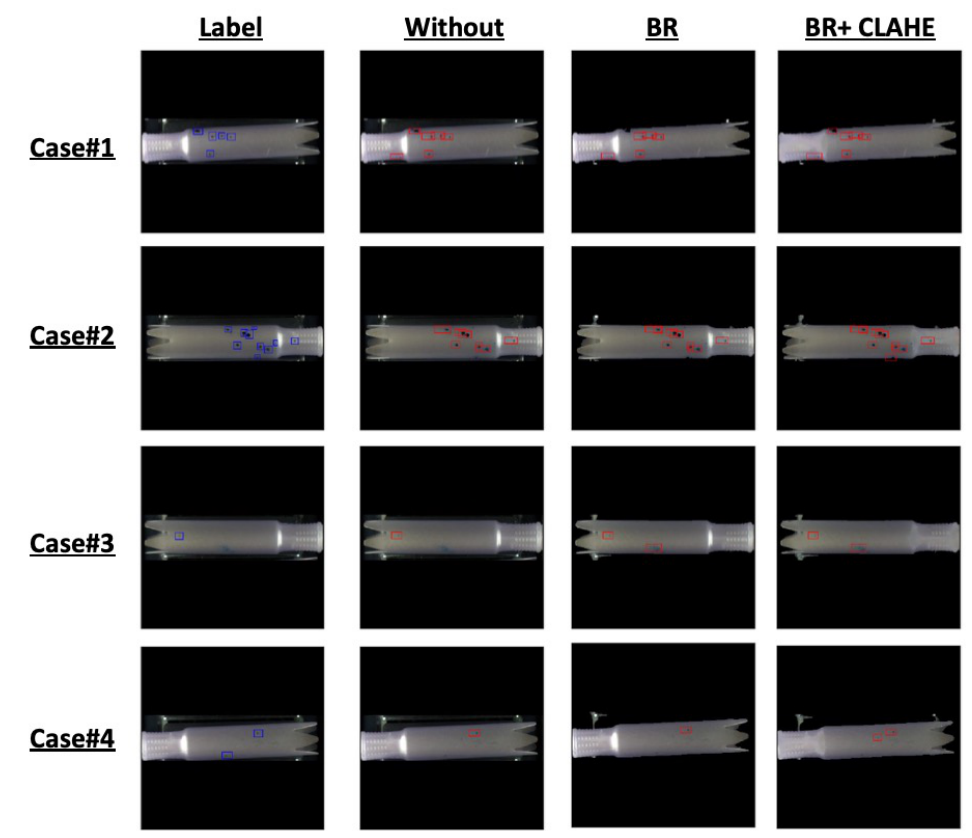
Figure 24. Analysis of object-detection